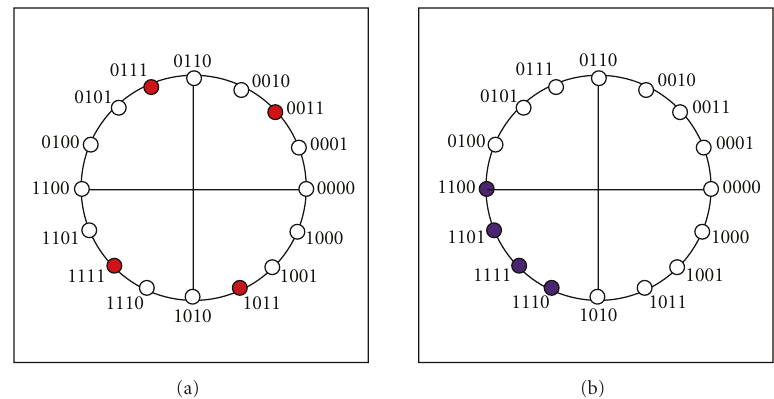
Figure 3: Two signal arrangement examples with Gray labeling 16-PSK where the nonshaping bits are 11. (a) The shaping bits choose the most significant bits (MSB). (b) The shaping bits choose the least significant bits (LSB).